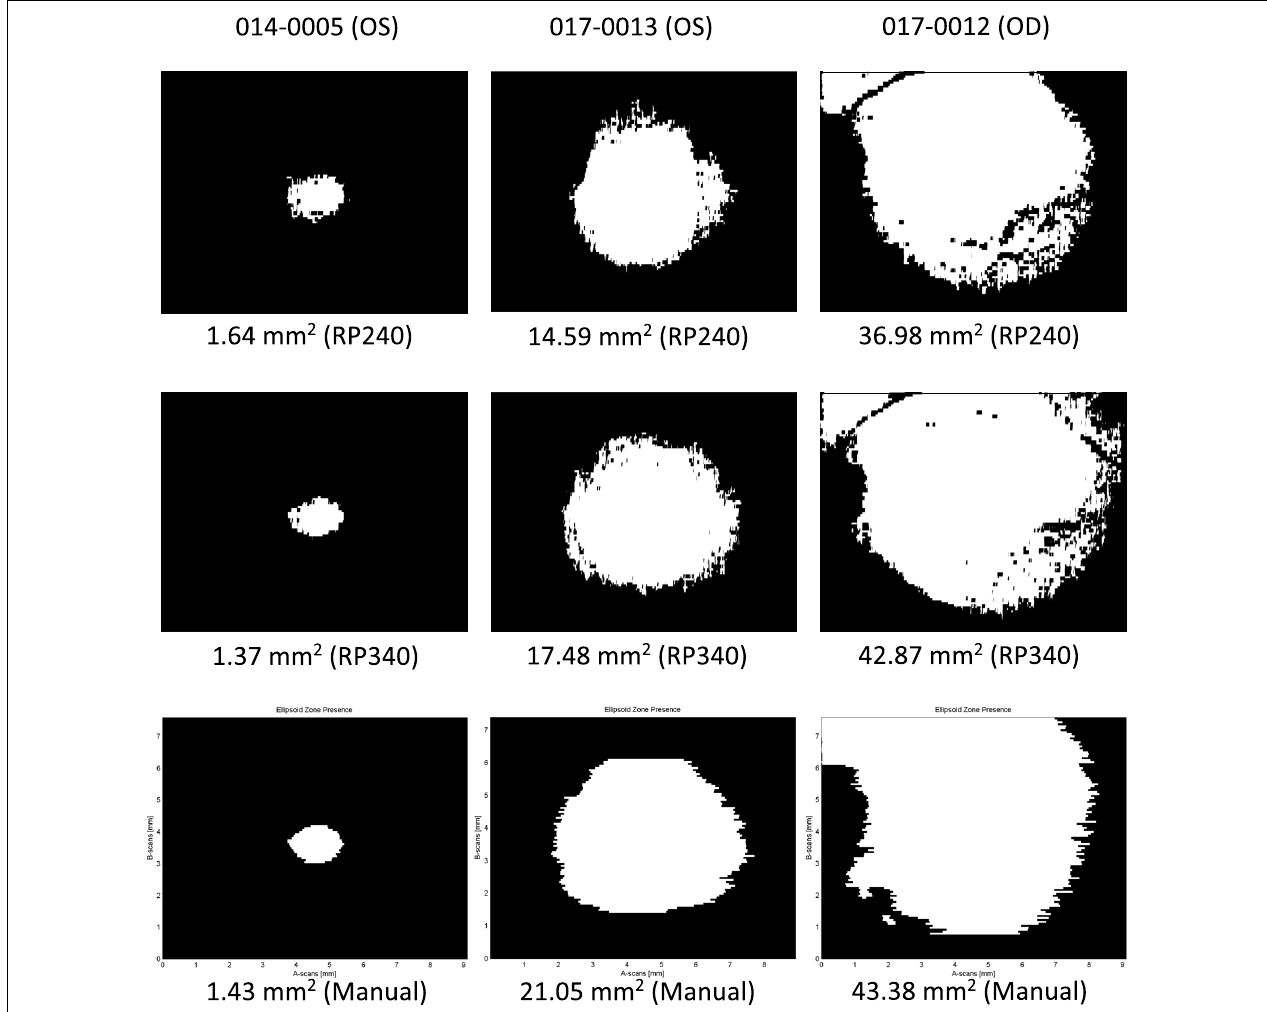
FIGURE 5 | Examples of ellipsoid zone (EZ) area presence determined by the deep learning models as well as the reading center. Top row: RP240 hybrid model; middle row: RP340 hybrid model; Bottom row: the reading center. Left column: small-size EZ; middle column: medium-size EZ; right column: large-size